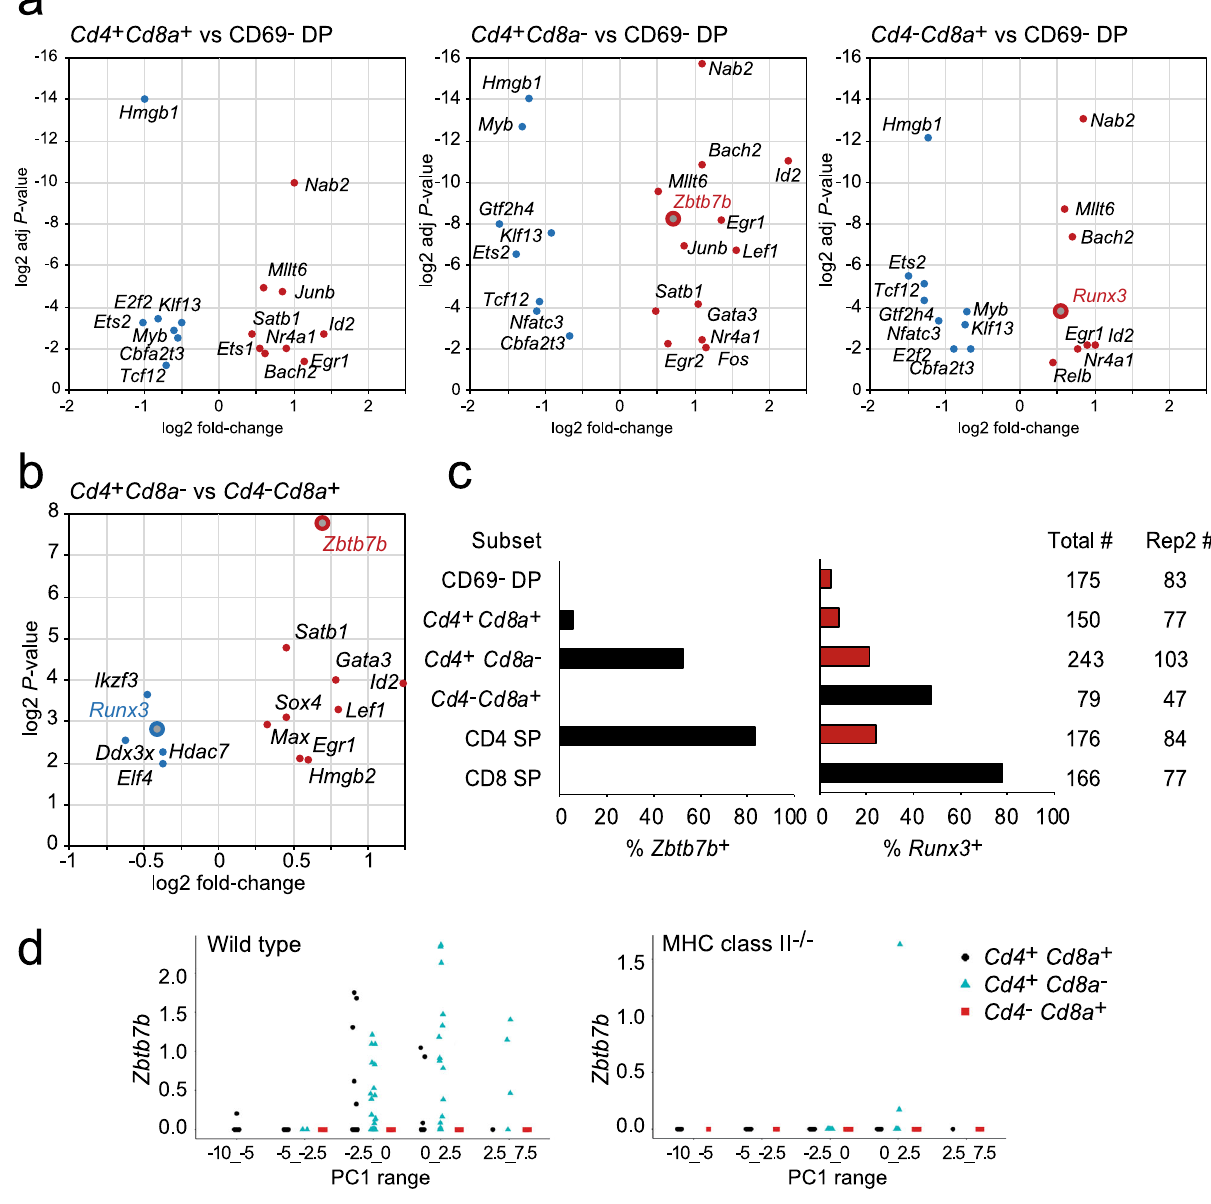
Fig. 4 Lineage-speci fi c expression of Zbtb7b but not Runx3 . a Differential expression of transcriptional regulators in Cd4 + Cd8a + (left), Cd4 + Cd8a − (middle) and Cd4 − Cd8a + selection intermediates (right) compared to CD69 − DP. Shown are log2 fold-changes and adjusted P -values (two-sided Wilcoxon rank-sum test). Zbtb7b and Runx3 are highlighted. Source data are provided as a Source Data fi le. b Differential expression of transcriptional regulators in Cd4 + Cd8a − versus Cd4 − Cd8a + selection intermediates. Shown are log2 fold-changes and nominal P -values (two-sided Wilcoxon rank-sum test). Zbtb7b and Runx3 are highlighted. Source data are provided as a Source Data fi le. c The frequency of Zbtb7b (left) and Runx3 expression (right) in the indicated thymocyte subsets is shown for wild-type replicate 2. Black: ‘ lineage-appropriate ’ expression. Red: ‘ lineage-inappropriate ’ expression. Source data are provided as a Source Data fi le. d The expression of Zbtb7b by selection intermediates of the indicated coreceptor gene expression status for different PC1 ranges in wild type (left) and MHC class II − / − thymus (right). Source data are provided as a Source Data fi